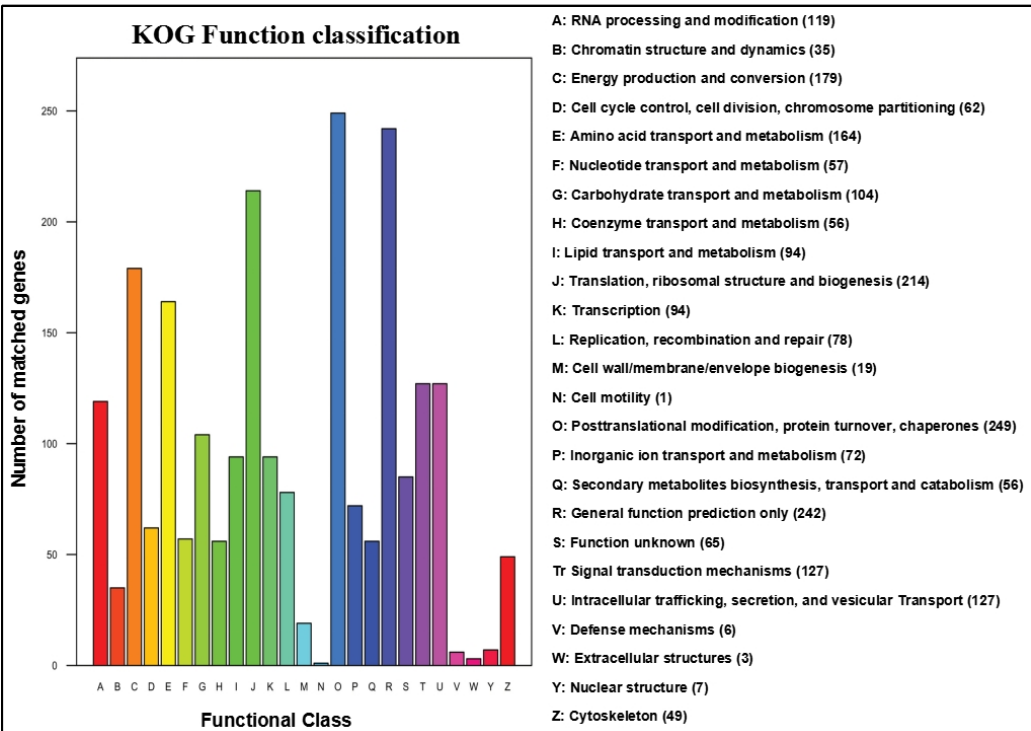
Figure 3. Clusters of orthologous groups of proteins (KOG) functional classification of proteins in A. rasikravindrae . In this figure, the X axis shows the functions of the class and the Y axis shows the number of matched genes. Although KOG function classification is divided into 26 groups categorized by A-Z. Different colors with their names and the number of genes is also mentioned.